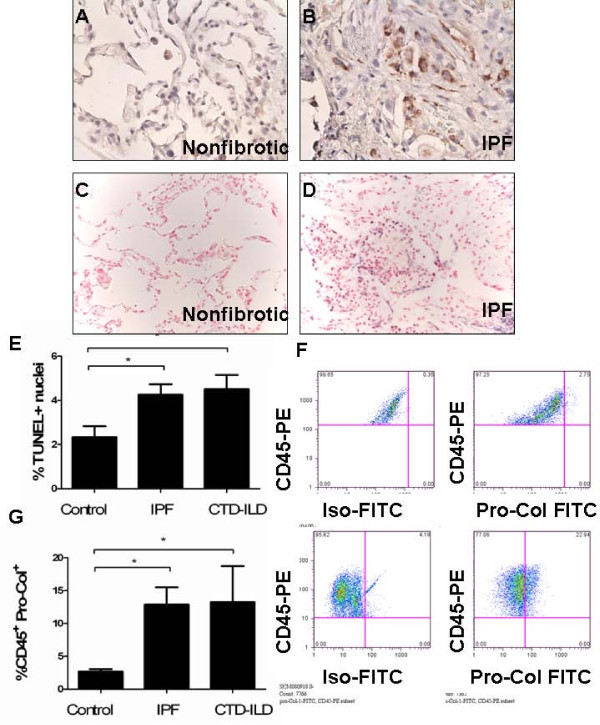
Fibrotic human lungs are enriched for terminal deoxynucleotidyl transferase dUTP nick end labeling (TUNEL) staining and CD45+Pro-collagen (Col)-Iα1+ cells. (a,b) Assessment of cleaved caspase 3 (brown cytoplasmic stain) on lung biopsy sample from (a) non-fibrotic and (b) idiopathic pulmonary fibrosis (IPF) lung sample. Nuclei are counterstained with hematoxylin (60 × original magnification). An increase in caspase cleavage is seen in the IPF lung. (c,d) TUNEL staining (black nuclear stain) performed on (c) non-fibrotic and (d) IPF lung shows an increase in TUNEL+ nuclei in the IPF lung. Nuclei are counterstained with nuclear fast red, 40 × original magnification. (e) Compared to non-fibrotic samples (left) TUNEL staining is increased in lungs obtained from subjects with IPF (middle) or connective tissue disease interstitial lung disease (CTD-ILD) (right). (f) CD45+Pro-Col-Iα1+ cells are increased in fibrotic lungs. Top left: intracellular isotype (x axis) versus CD45-PE (y axis) on cells obtained from a non-fibrotic lung. The diagonal morphology of the cells reflects the high inherent autofluorescence of lung inflammatory cells. Top right: Pro-Col-Iα1- fluorescein isothiocyanate (FITC) (x axis) versus CD45-PE (y axis) on non-fibrotic lung. There is only minimal shift past the isotype control. Bottom left: intracellular isotype (x axis) versus CD45-PE (y axis) in cells obtained from an IPF lung. Bottom right: Pro-Col-Iα1-FITC (x axis) versus D45-PE (y axis) on IPF lung. (g) Compared to non-fibrotic subjects (n = 6) (left), detection of CD45+Pro-Col-Iα1+ cells is increased in the lungs of subjects with either IPF (n = 4, middle) or CTD-ILD (n = 4, right). *P < 0.05 **P < 0.01.